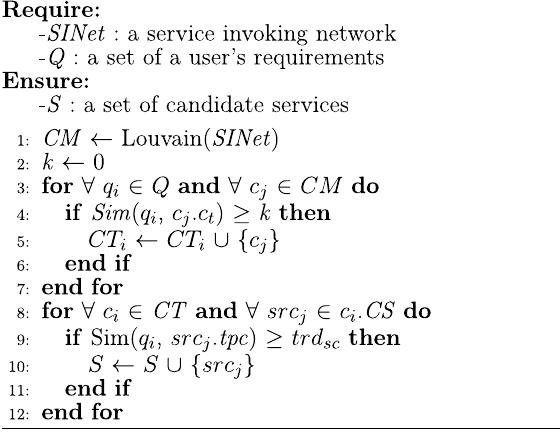
Algorithm 4. Candidate service discovery